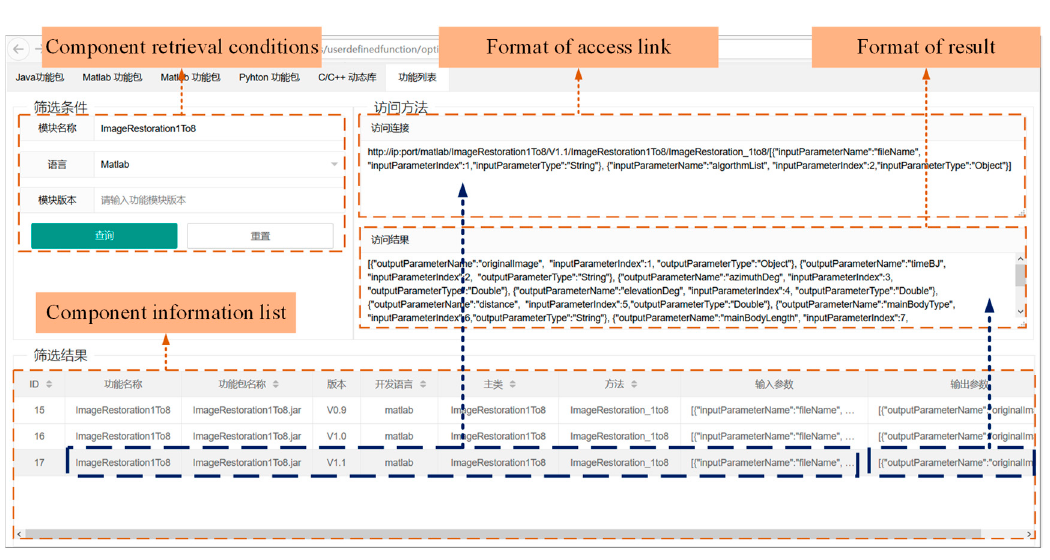
Figure 1. Module list and information retrieval. The format of the access link and the processing result of the selected algorithm can be obtained.